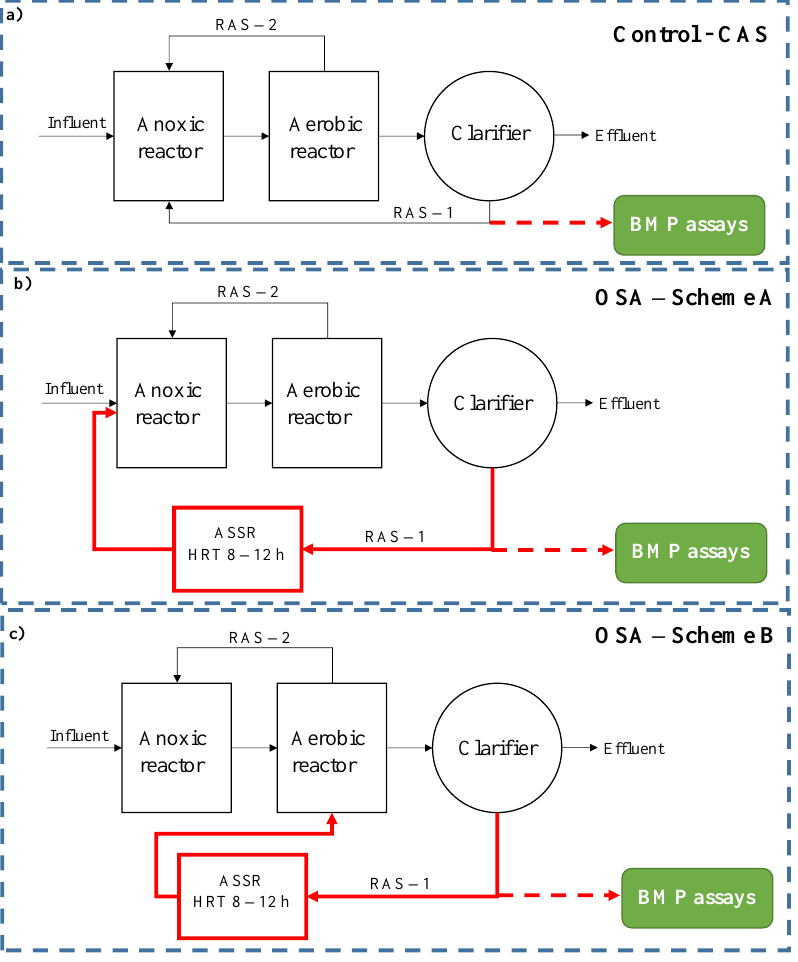
Figure 1. Layouts of the ( a ) control-CAS and ( b , c ) OSA plants according to scheme A and scheme